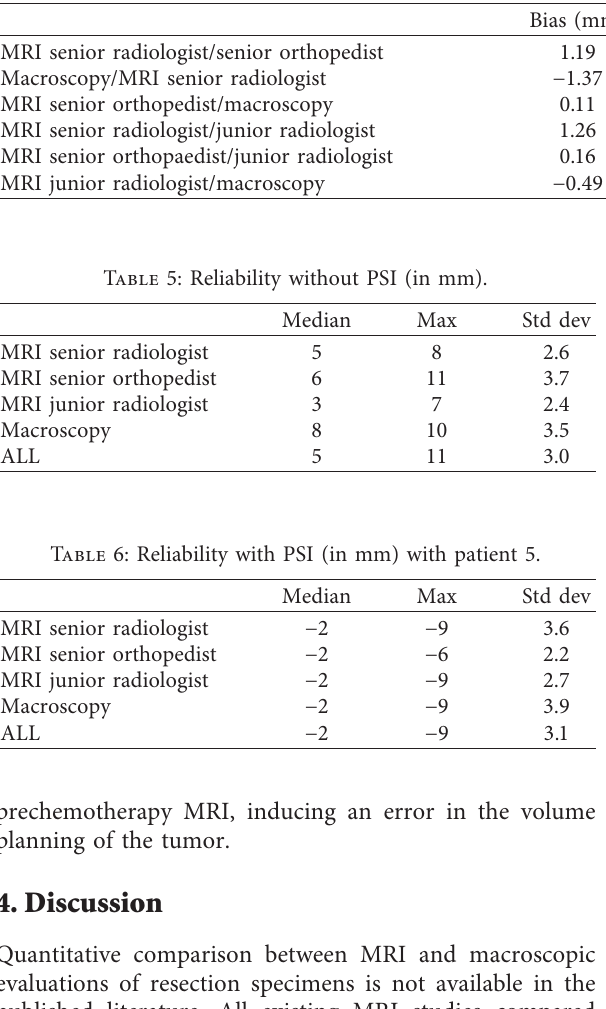
Table 4: Bias between the methods.